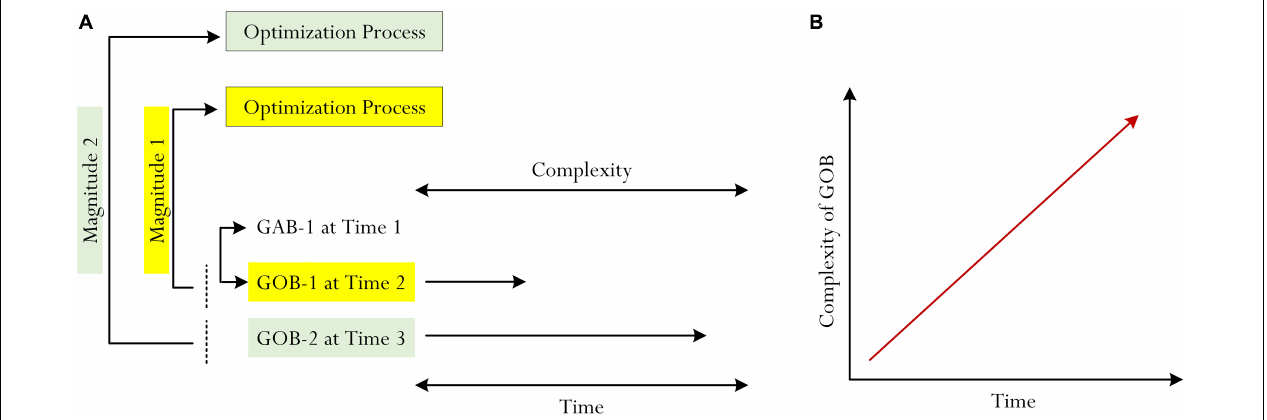
FIGURE 3 | Complexity of GOB and the magnitude of optimization. (A) shows the magnitude of the process of optimization and (B) shows the complexity of